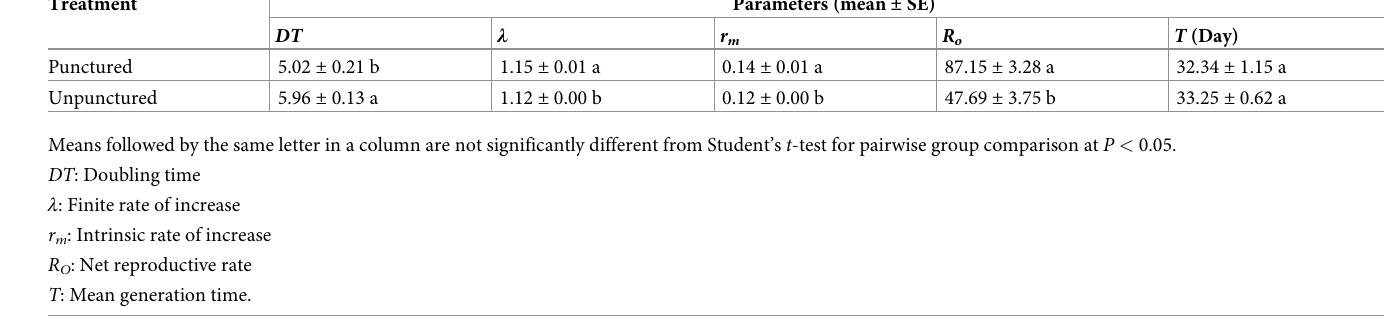
Table 4. Life table parameters of G . molesta reared on punctured and unpunctured apples .